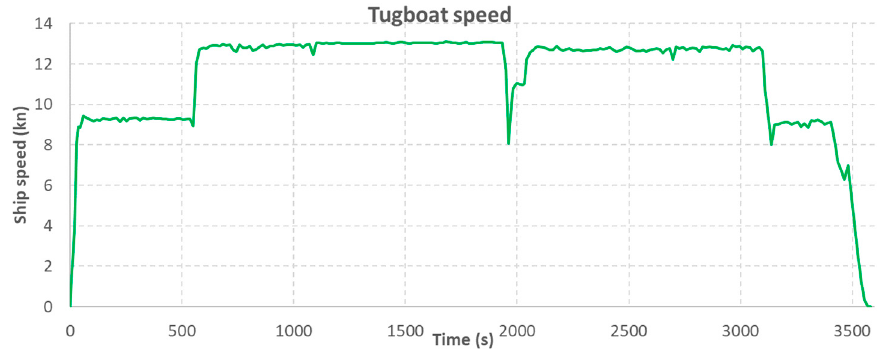
Figure 20. Speed of the simulated tugboat.